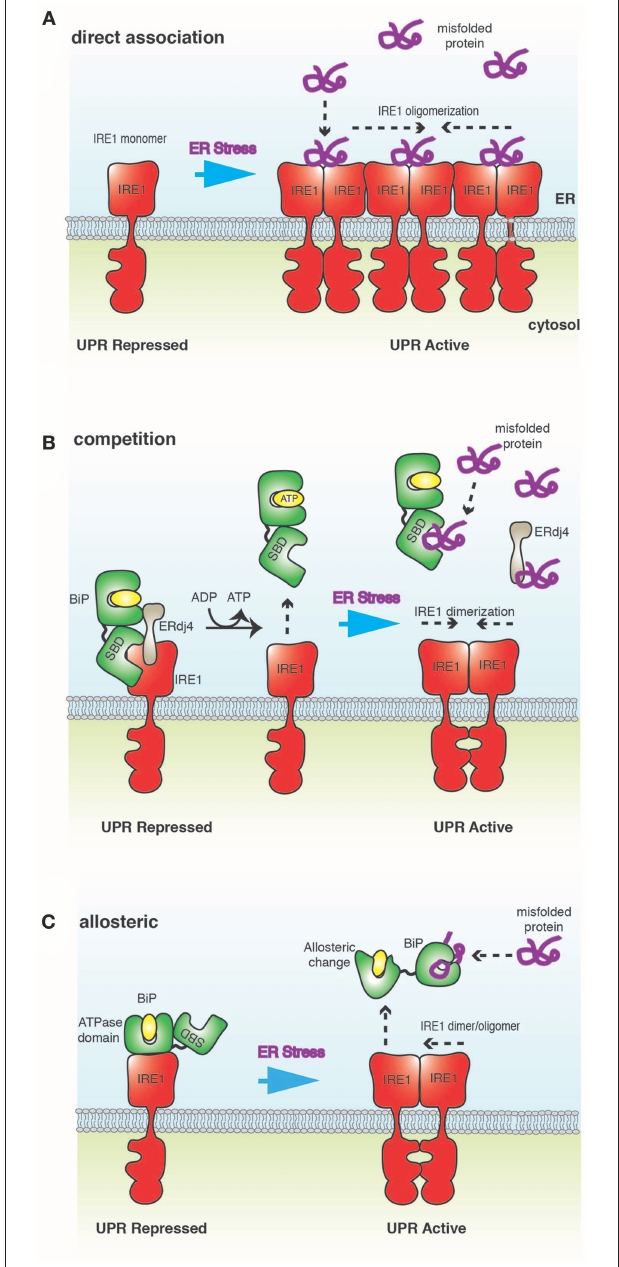
FIGURE 3 | A schematic representation of ER stress-sensing mechanisms. (A) Direct association model posits that misfolded proteins bind directly to IRE1 LD, resulting in oligomerization of IRE1 and activation of UPR. (B) In the competition model, IRE1 LD binds to BiP SBD in a chaperone-substrate type interaction. This is the same site that misfolded proteins bind to BiP, leading to a competition for this binding site. BiP interaction to IRE1 is mediated by ERdj4, which ultimately inhibits UPR signaling by facilitating the formation of IRE1 LD monomer. Thus, BiP acts as a repressor of UPR signaling, but is not a direct sensor of ER stress. (C) In the allosteric model, the binding of misfolded proteins and IRE1 LD to BiP occur on different domains; thus, obviating the requirement for competition. Misfolded protein binding induces a conformational change that releases BiP from IRE1, implicating BiP as a direct sensor of ER